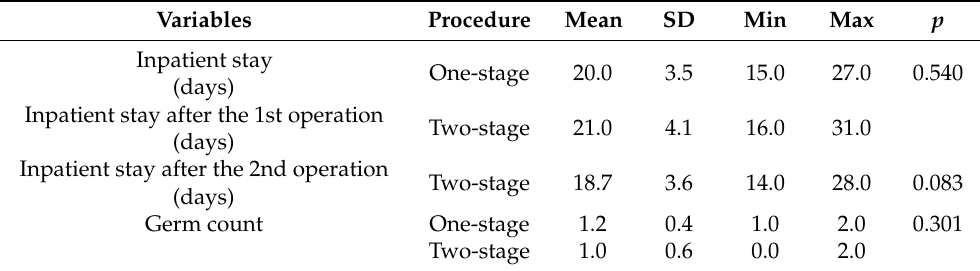
Table 2. Detailed information about the length of stay and germ count between both